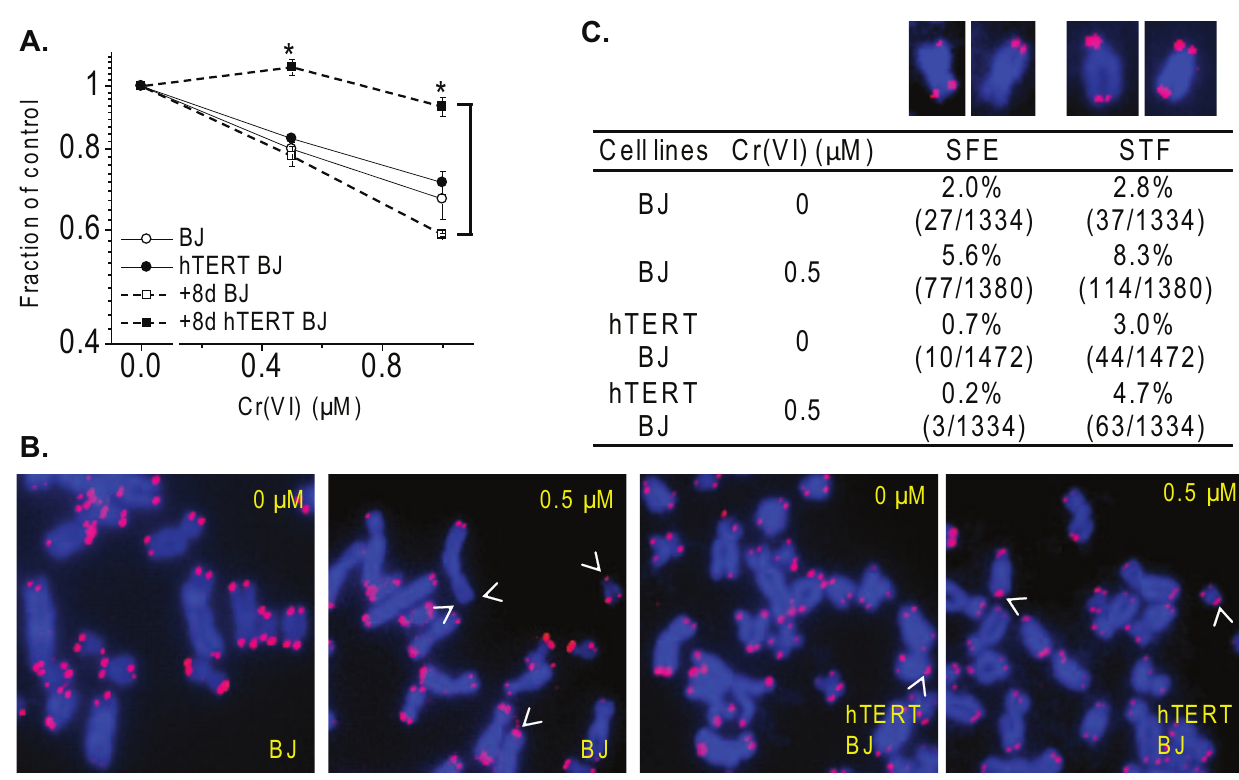
Figure 1. Telomerase expression attenuates Cr(VI)-induced cytotoxicity and telomere aberrations. (A) Cell viability assay. The cells were exposed to the indicated Cr(VI) concentrations for 48 h, and subpopulation of Cr(VI)-treated cells were subcultured in Cr(VI)-free medium for 8 days. (B) Images are representative telomere FISH of partial metaphases from cells exposed to 0 or 0.5 m M Cr(VI) for 48 h and cultured in Cr(VI)-free medium for 10 h. Arrows heads indicate telomeric defects that appeared in each of the focal planes of the Z-stack series (see Materials and Methods), although only one focal plane is shown. (C) Frequencies of Cr(VI)-induced telomere aberrations. Values in parenthesis indicate the number of abnormal chromosomes/ total chromosomes. Telomere signal free ends, SFEs; sister chromatid telomere fusions, STFs. Insets show examples of two SFEs, followed by two